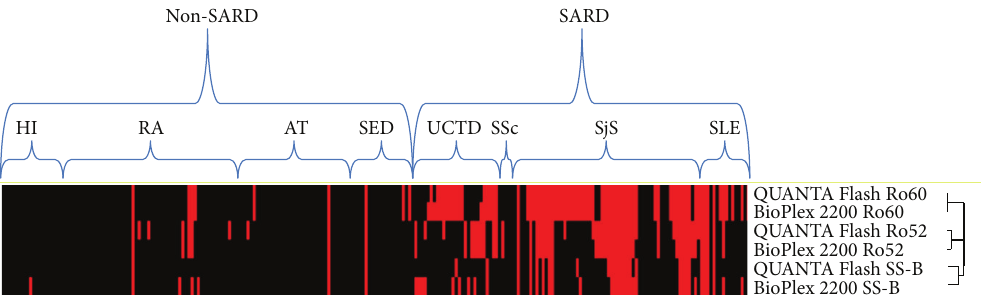
Figure4:Supervisedclusteranalysisoftheresults.Supervisedcenteredclusteranalysisaccordingtodiseasecohortisshown.Thedendrogram showsthattheRo60assaysarecloselyrelated,theRo52assaysaresomewhatrelated,andtheSS-Bassaysshowsignificantdifference.AT:atopic dermatitis; UCTD: undifferentiated connective tissue disease, RA: rheumatoid arthritis, SSc: systemic sclerosis; SED: suspected eye disease, SLE: systemic lupus erythematosus; HI: healthy individuals; SARD: systemic autoimmune rheumatic